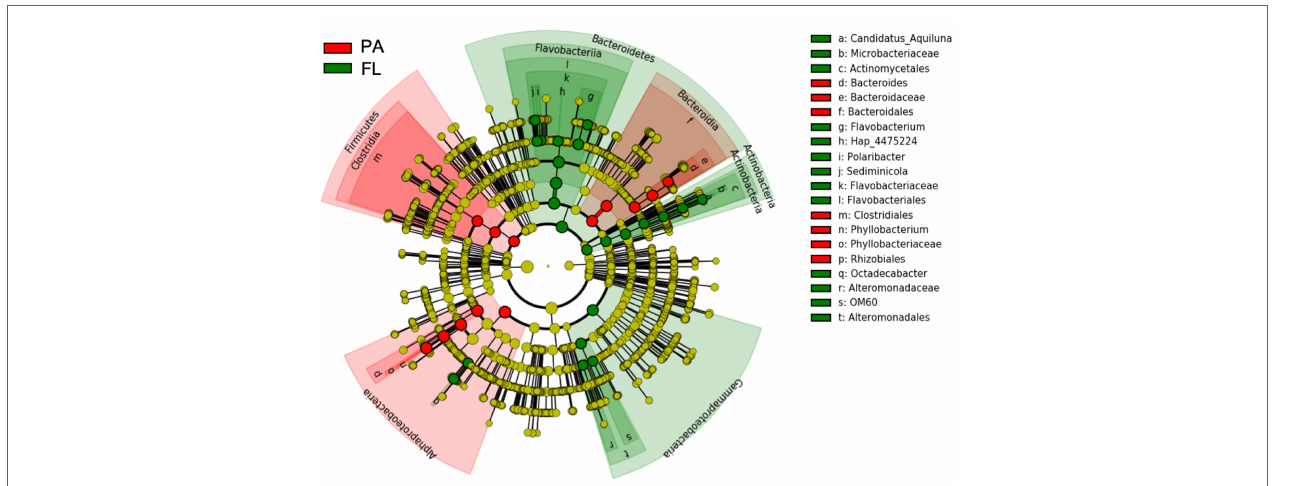
FIGURE 6 | LEfSe analyses (LDA >4; p = 0.05) showing the taxonomic groups that statistically differentiate FL (green) and PA (red) communities using the prokaryotic ASVs table. Taxa with non-significant differences are presented as yellow circles and the diameter of the circles is proportional to relative abundance. Circles represent taxonomic levels from phyla (innermost ring) to genus (outermost ring). On the right, the list of taxa represented in the taxonomic hierarchical